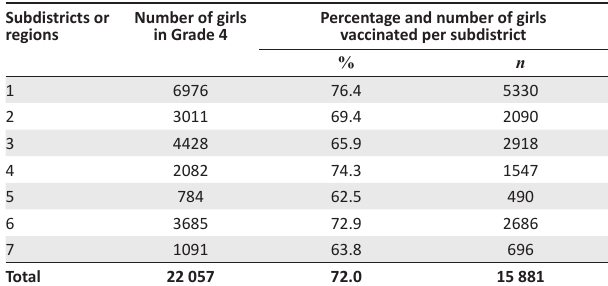
TABLE 1: Vaccine uptake among Grade 4 girls in Tshwane’s subdistricts ( N = 22 057). Subdistricts or Number of girls regions in Grade